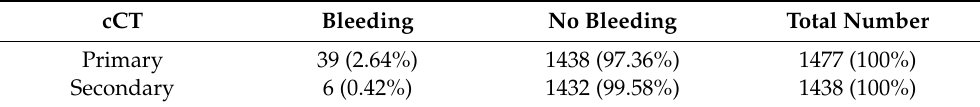
Table 3. Distribution of cCT findings with “bleeding” and “no bleeding” among all